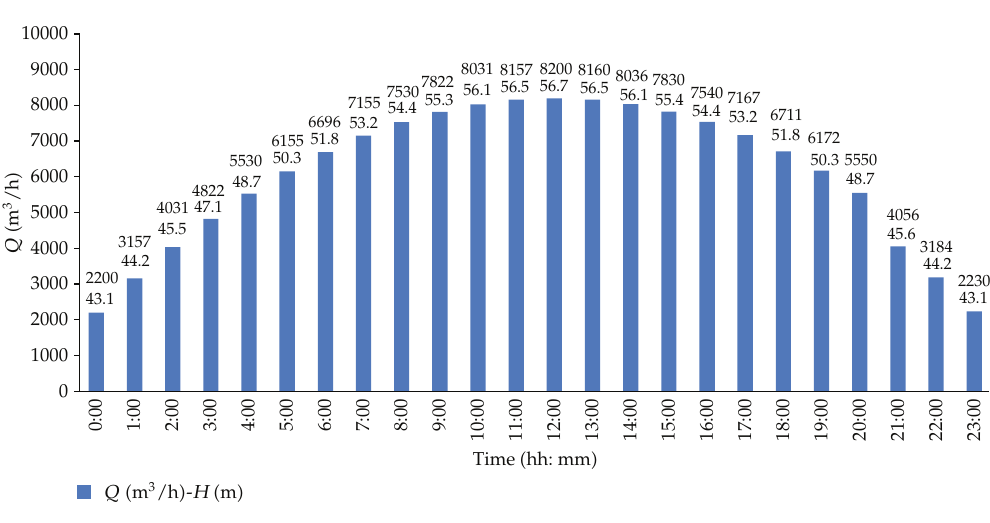
Figure 8: Daily supply